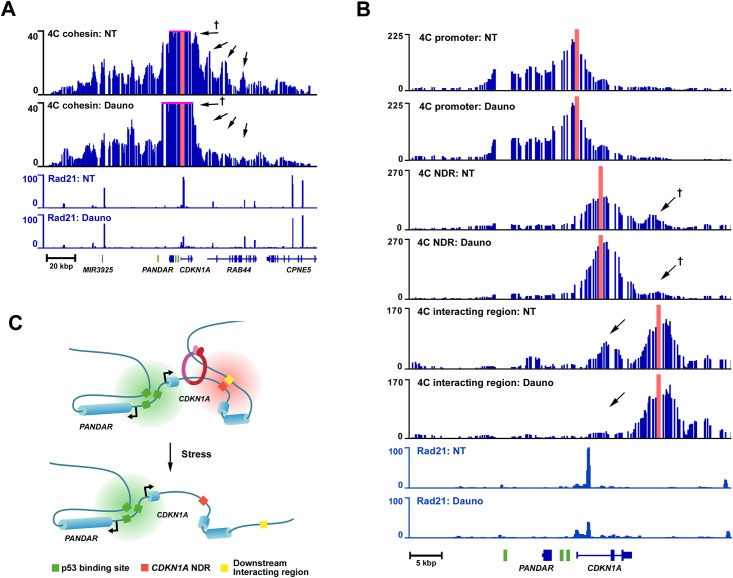
The spatial organization of the CDKN1A locus is remodeled in response to stress.(A) 4C high-resolution interaction map of CDKN1A’s intragenic cohesin site. HCT116 p53+/+ cells were treated (Dauno) or not (NT) with daunorubicin. The 4C cohesin site viewpoint is highlighted in red; Rad21 ChIP-seq tracks are also shown. P53 binding sites are indicated in green in the gene track. (B) 4C high-resolution interaction map of the CDKN1A locus. HCT116 p53+/+ cells were treated (Dauno) or not (NT) with daunorubicin. The 4C tracks for the promoter, nucleosome-depleted region (NDR), and interacting region are presented with their respective viewpoints in red. Rad21 ChIP-seq tracks are also shown. P53 binding sites are shown in green in the gene track. (C) Model of the dynamic spatial organization of the CDKN1A locus in response to stress. (†) Indicates the same 4C peak between (A) and (B).